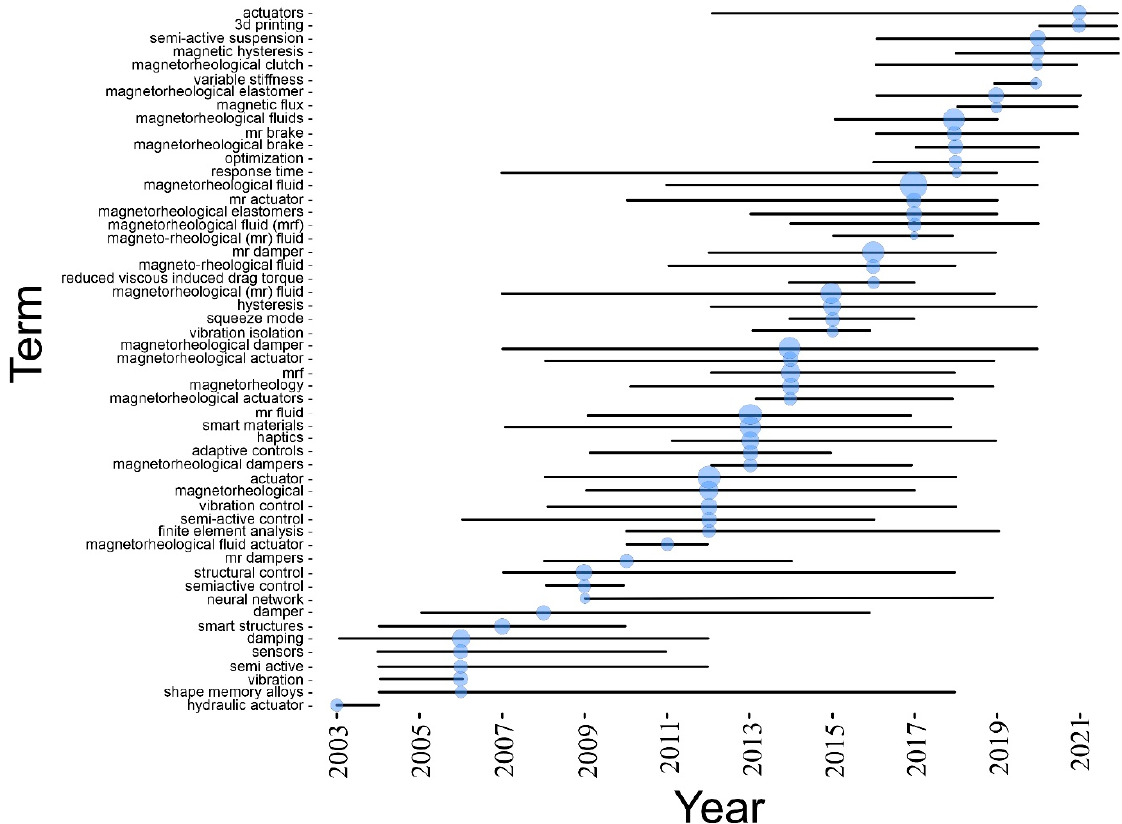
Figure 20. Treemaps of the keywords and scientific article titles used in the Scopus database.